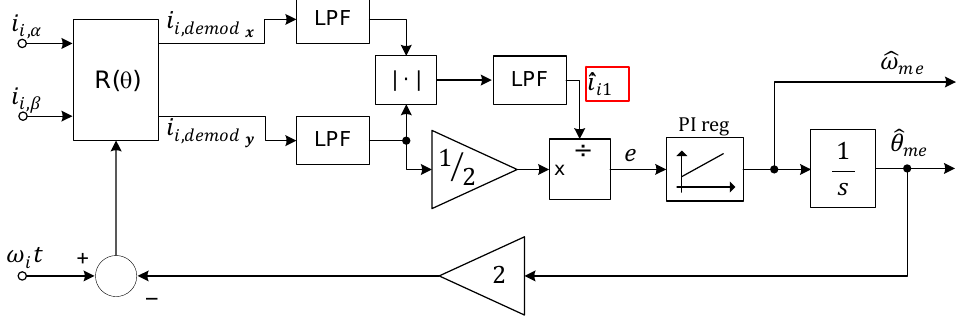
Figure 5. PLL schematic adopting the proposed gain adaptation.